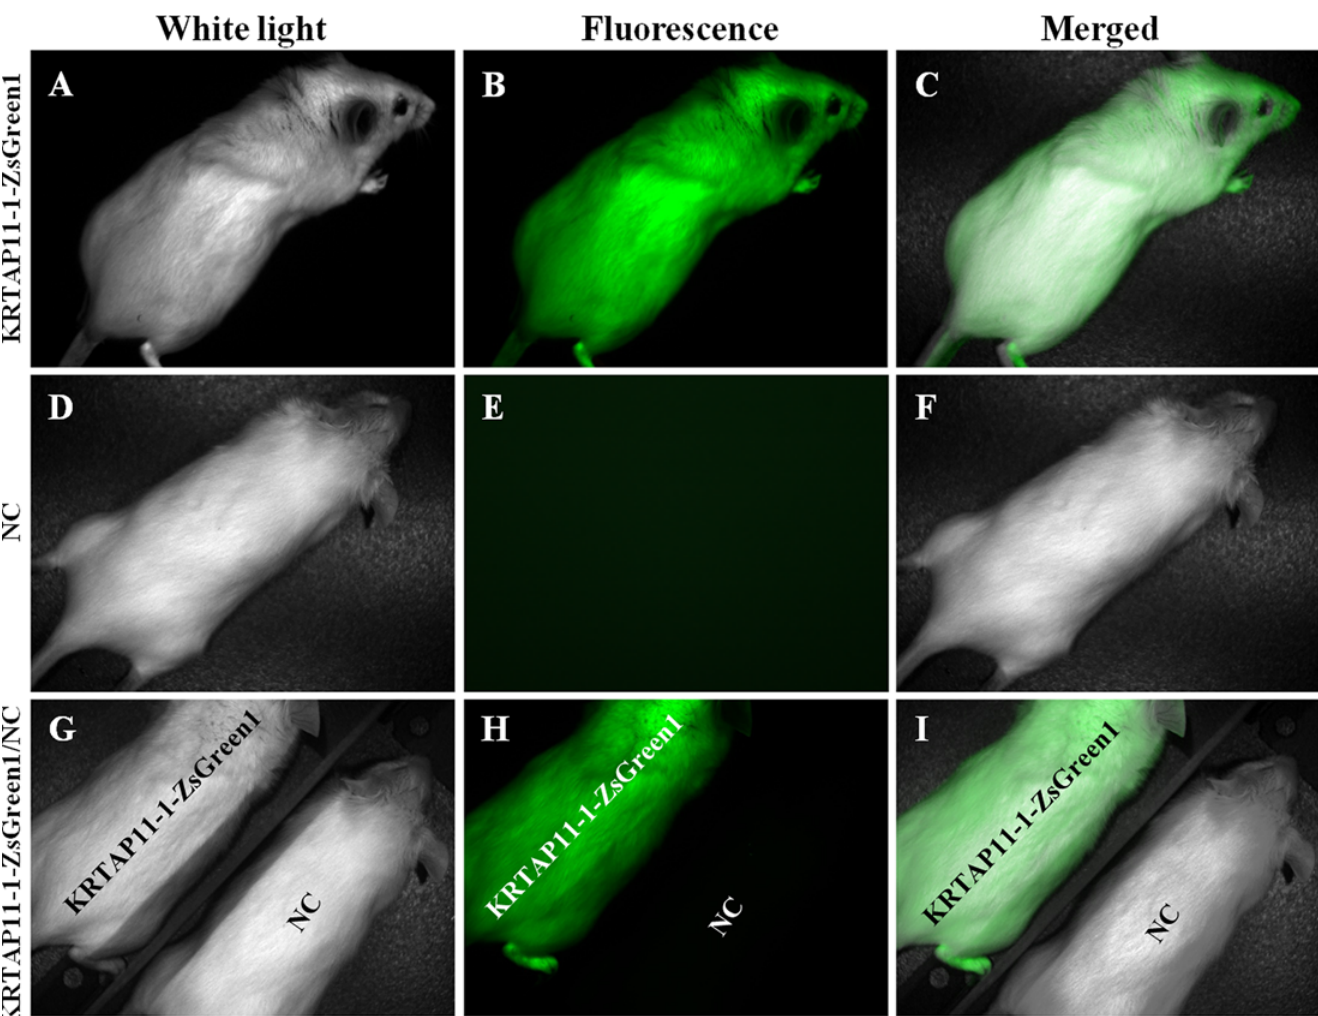
Fig 5. Fluorescence images of the KRTAP11-1-ZsGreen1 transgenic mouse obtained using the whole-body imaging system. (A) KRTAP11- 1-ZsGreen1 transgenic mouse under white light. (B) KRTAP11-1-ZsGreen1 transgenic mouse under fluorescent light. Strong ZsGreen1 fluorescent signals were detected in the KRTAP11-1-ZsGreen1 transgenic mouse. (C) Merged picture (A) and (B); (D) Negative mouse (NC) under white light; (E) Negative mouse under fluorescent light. No ZsGreen1 fluorescent signal was found in the negative mouse; (F) Merged picture (D) and (E); (G)